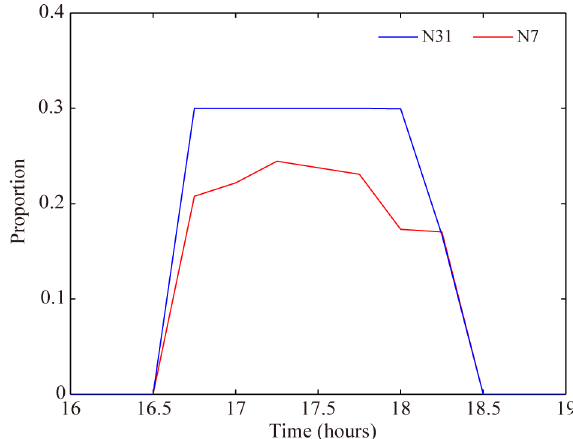
Figure 15. Proportion of the actual consumed power exceeding the dispatching order.